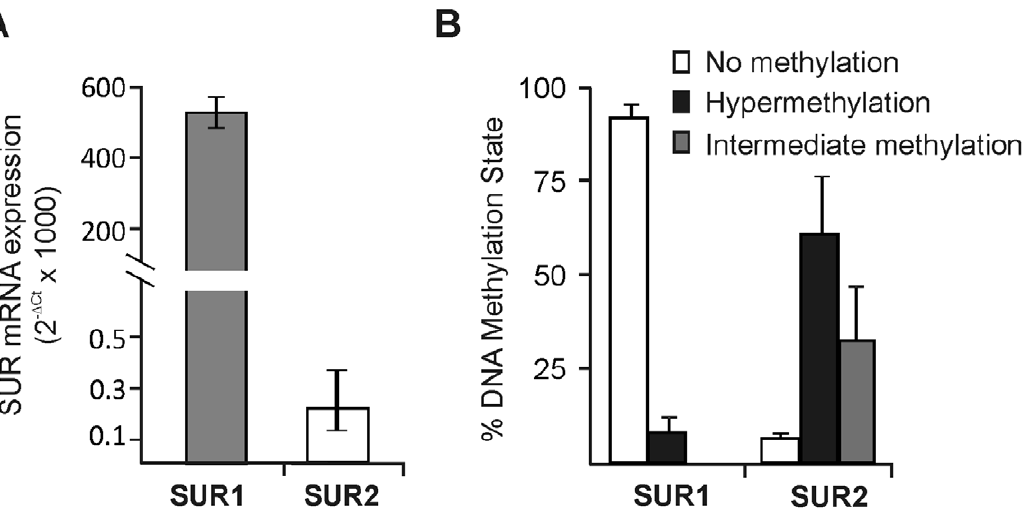
Figure 3. SUR1 and SUR2 expression in HL-1 cells and correlation with CpG island methylation. (A) Relative mRNA expression of SUR1 and SUR2 in HL-1 cells (n=3). As in the atrium, SUR1 expression is markedly greater than SUR2. (B) The relative absence of SUR2 expression in HL- 1 cells is correlated with CpG island methylation. Shown are summary results of methylation state determined using the EpiTect assay (SABiosciences) using primers specific for SUR1 CpG island (cat # MePM09623-2A) and custom primers (see methods for sequences) that amplify the SUR2 CpG island sequence.